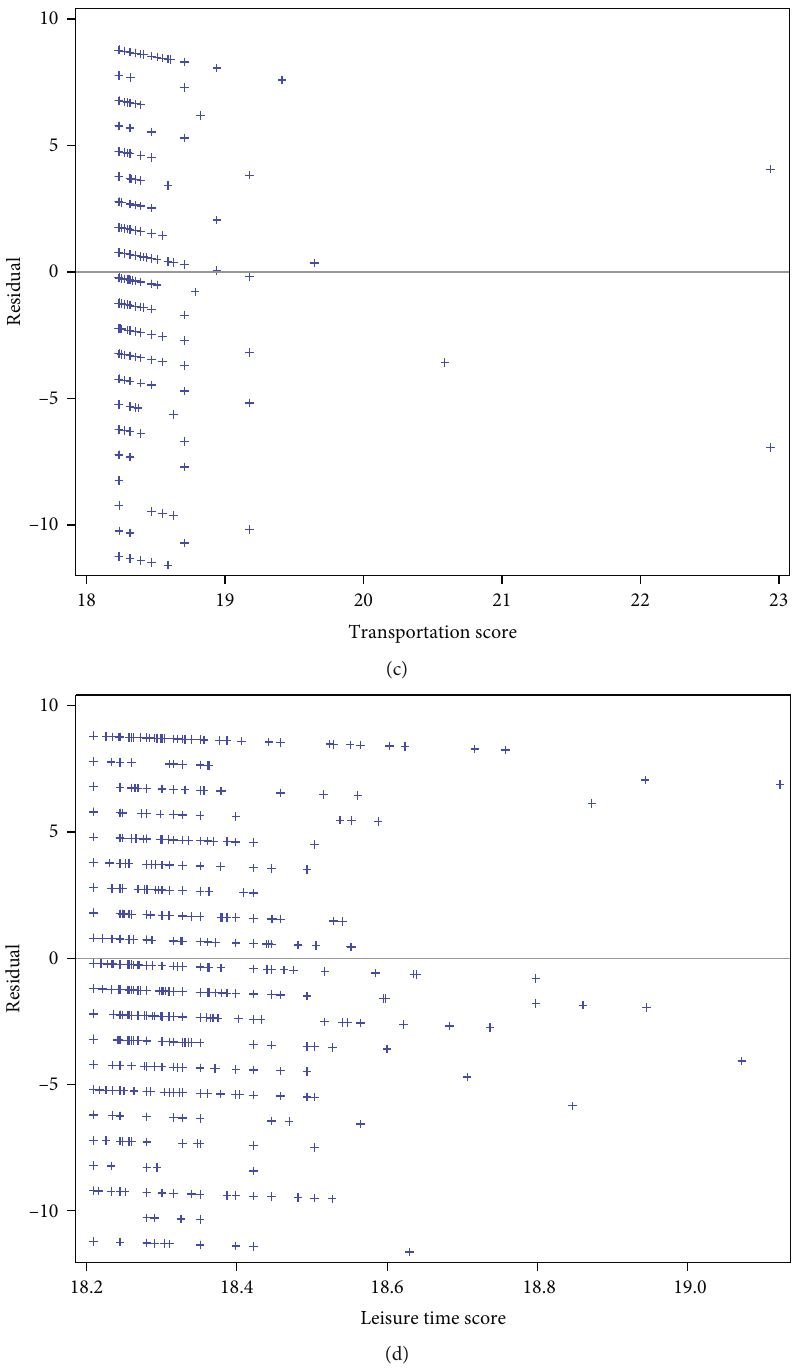
Figure 3: The residual graph of linear fi tting between scores of (a) domestic, (b) occupational, (c) transportation, and (d) leisure time activities and cognitive function